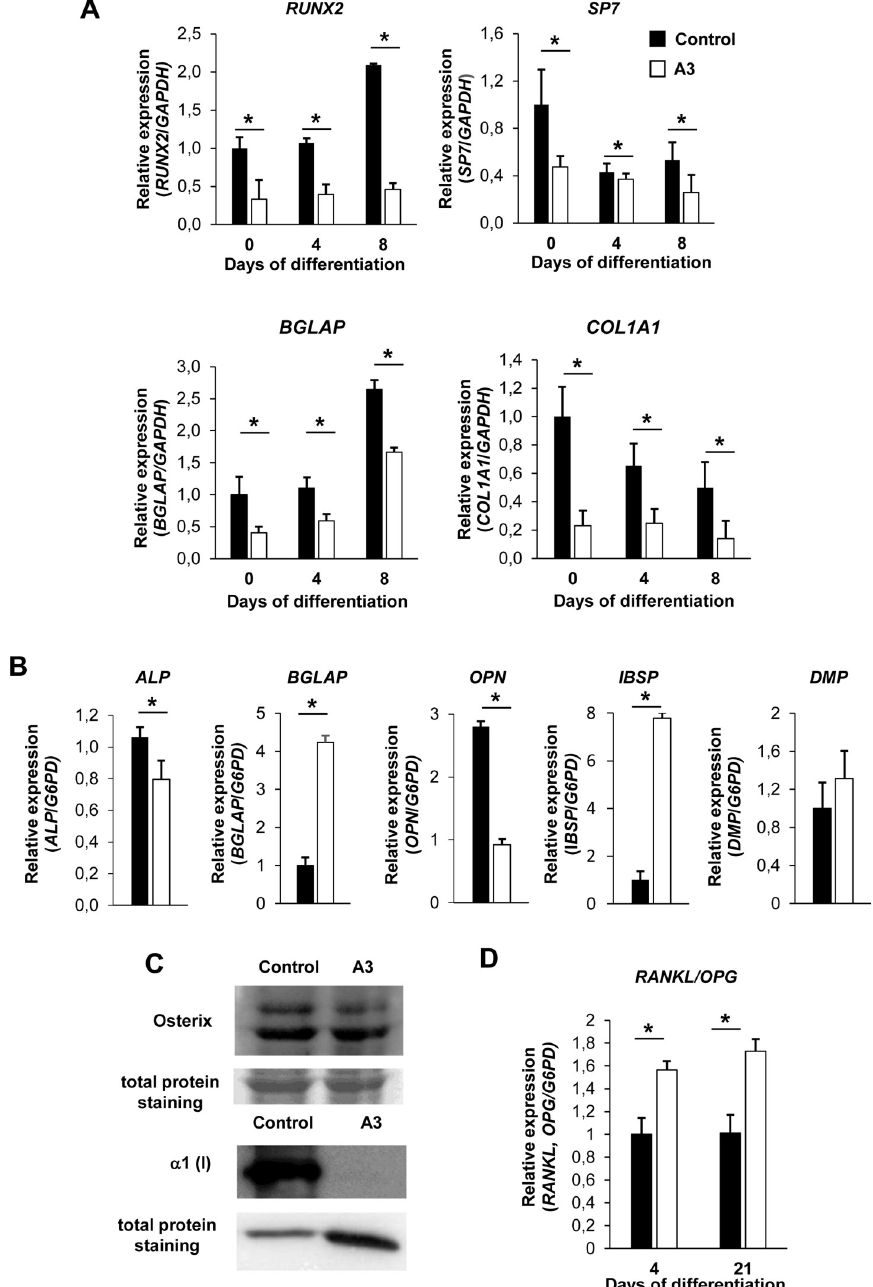
Fig 3. Expression analysis of osteoblastogenic markers and of the RANKL/OPG ratio. (A) RUNX2 , SP7 , BGLAP and COL1A1 expression was reduced in A3 mutant clone with respect to control cells at all time points analysed during hFOB differentiation. (B) ALP , BGLAP , OPN , IBSP , DMP expression was evaluated following 21 days in osteoblastic differentiation medium. ALP and OPN expression was reduced while BGLAP , IBSP and DMP expression was increased in A3 mutant clone with respect to control cells. (C) A reduced collagen I and a slightly reduced osterix expression were detected by western blot analyses in mutant clone. (D) Measurements of RANKL/OPG ratio. qPCR analysis showed an increased ratio in the mutant clone A3 at both 4 and 21 days. � p < 0.05.